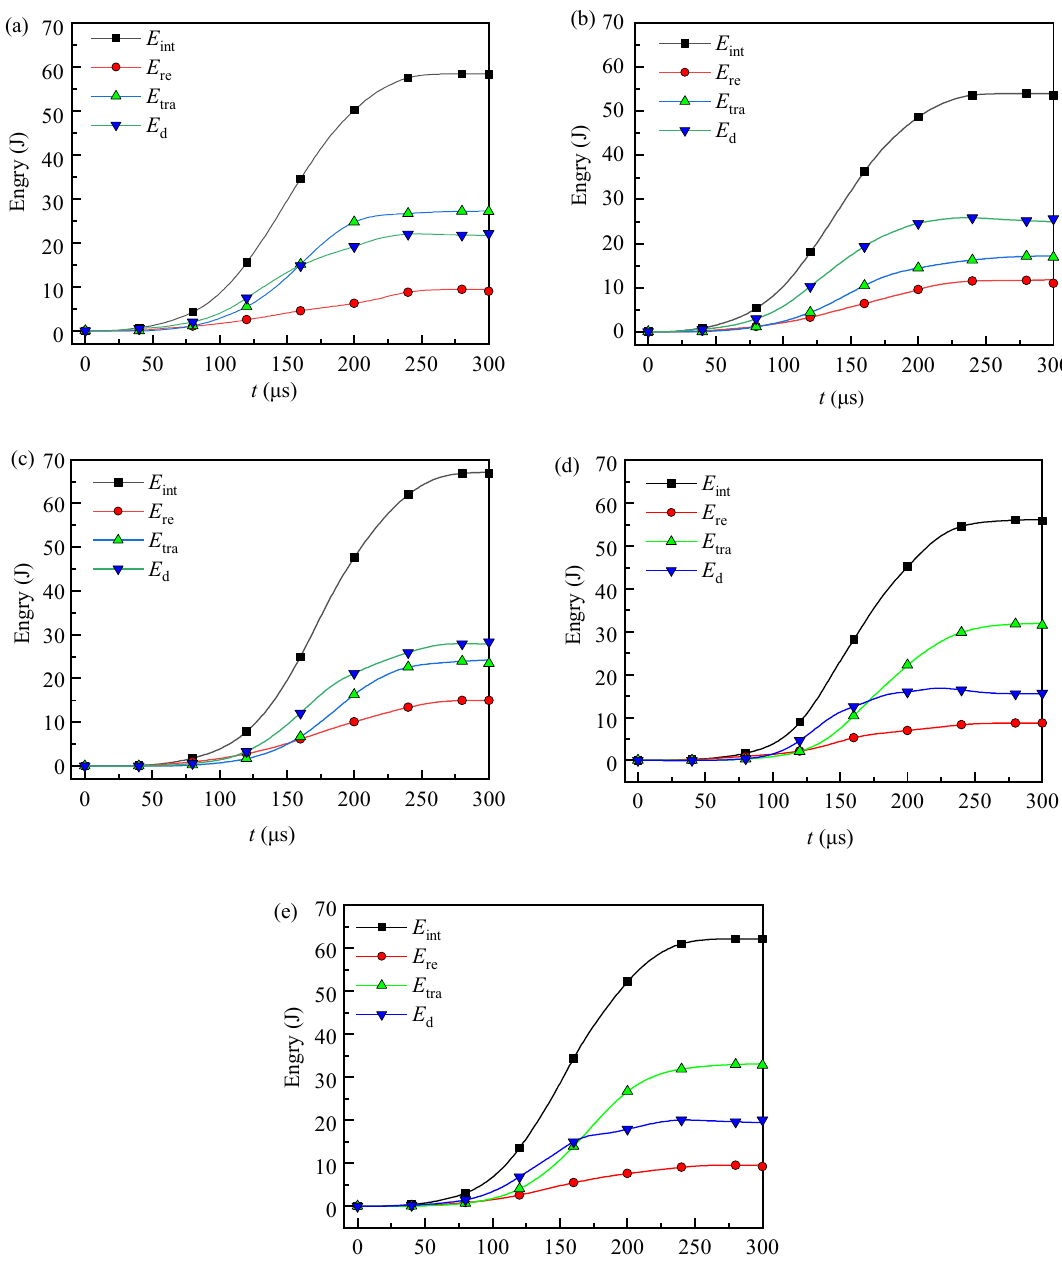
Figure 6. Energy time history curves of the specimen with different length–diameter ratios ( a ) n = 0.6 ( b ) n = 0.8 ( c ) n = 1.0 ( d ) n = 1.2 ( e ) n = 1.4.